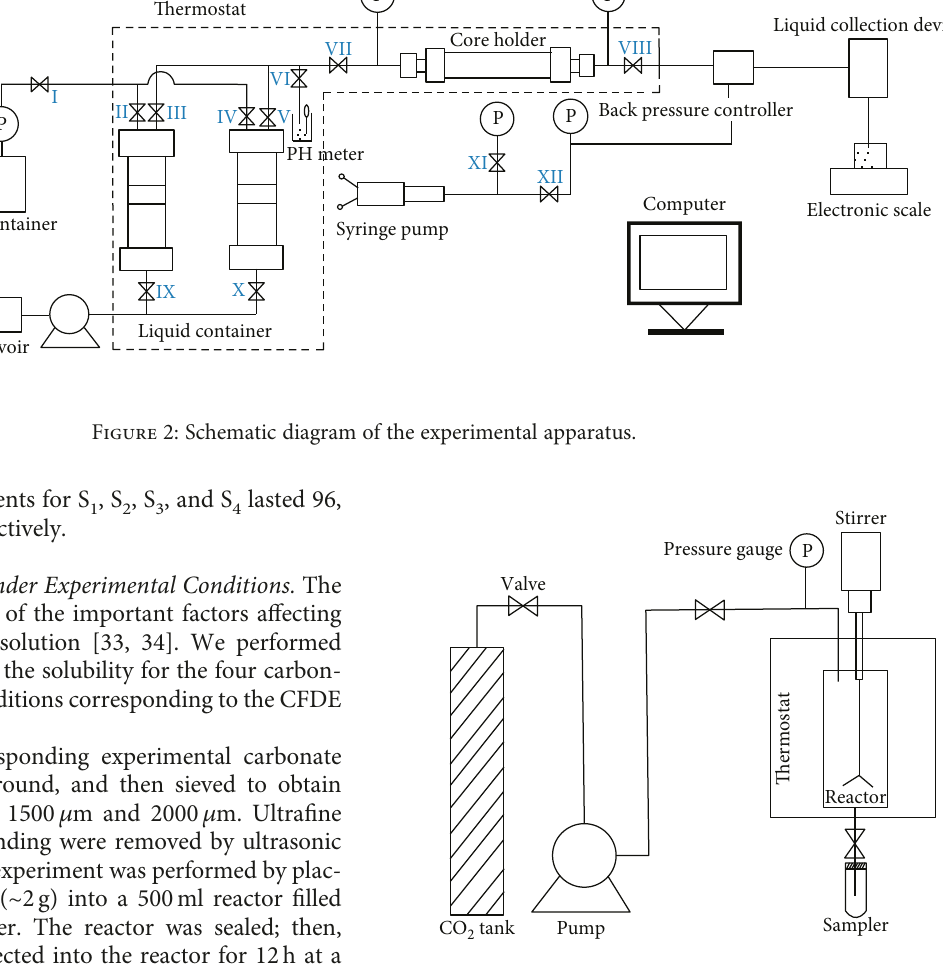
Figure 3: Schematic diagram of the calcite solubility measurement apparatus.